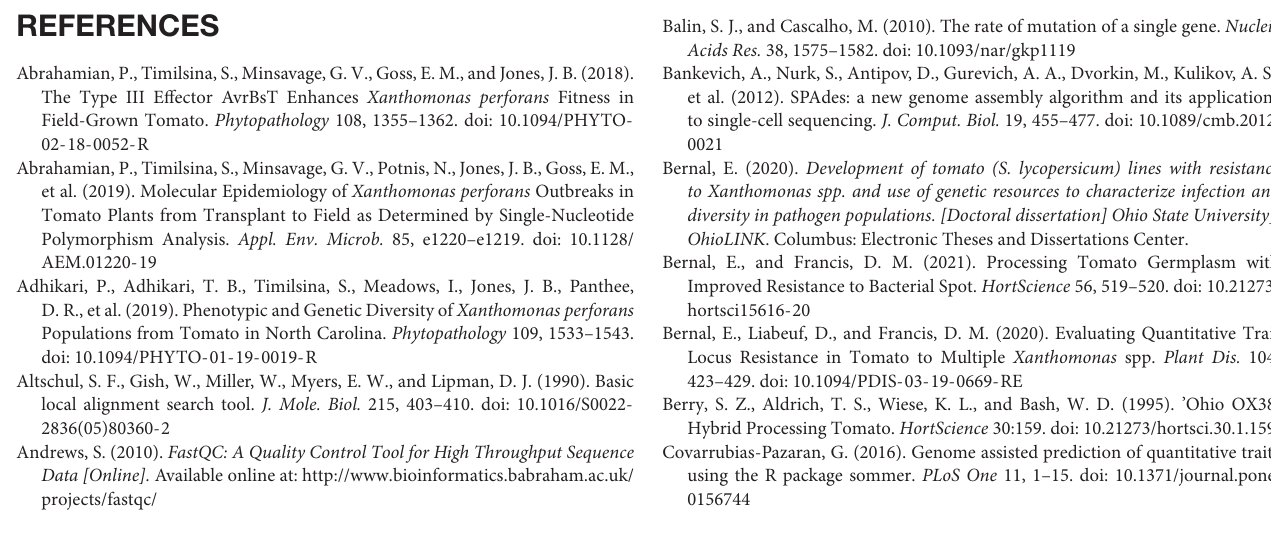
Supplementary Figure 1 | Comparison of Multilocus Sequence analysis (MLSA) Tree, Average Nucleotide Identity (ANI) Tree, and Parsnp Tree. MLSA, ANI, and Parsnp trees, containing 39 X. perforans strains, were developed to compare and identify known groups and clades. (A) Concatenation of five house-keeping genes, lepA, gyrB, lacF, gapA, and gltA, was used to build the MLSA phylogenetic tree. (B) Whole genome sequence was used for the ANI phylogenomic tree. (C) Whole Genome sequence was used for Parsnp phylogenomic tree. Strains are denoted by the name, location of isolation, year, race-type, and known mutation in avrXv3